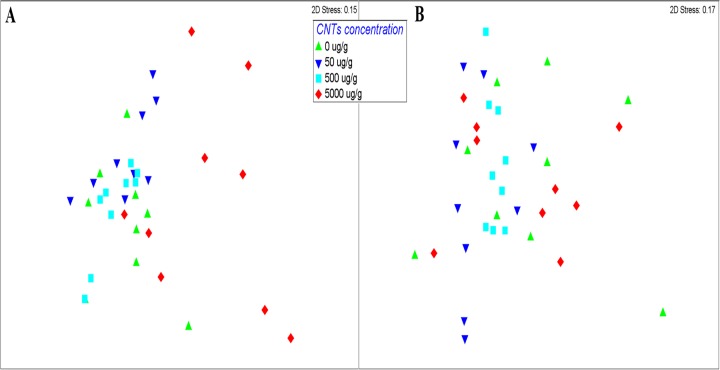
NMDS of Bray-Curtis Index of bacterial community composition in relation to (A) fMWCNTs and (B) raw MWCNTs concentrations applied to soil among the different treatments.